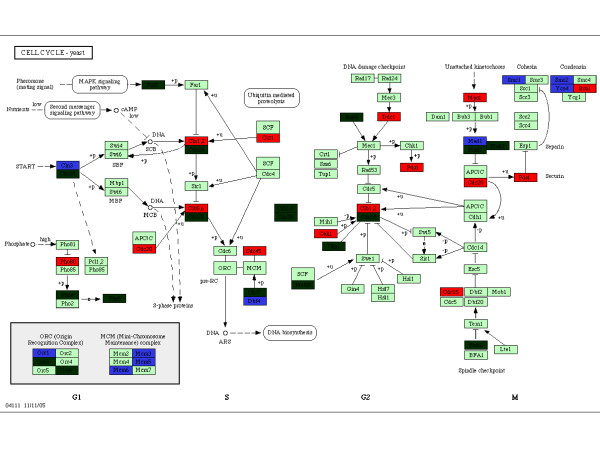
Cell cycle pathways in S. cerevisiae. The pathway figure was downloaded from KEGG database. Genes from Group I, II and III were denoted in red, blue and light green, respectively. Genes with dark green were not included in our orthologous matrix because they might be missing from one of the studied species.